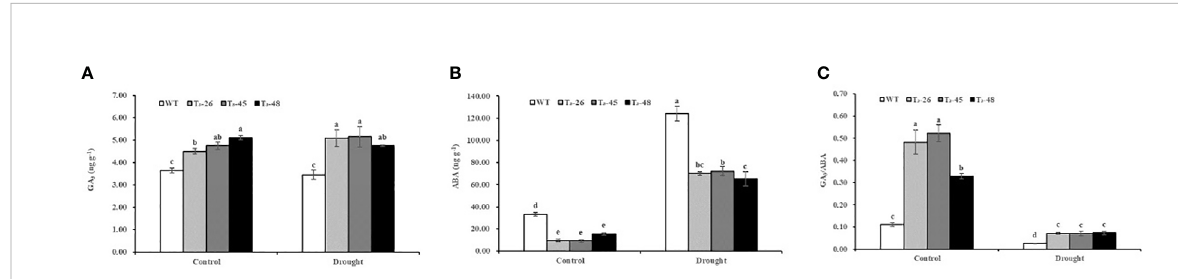
FIGURE 4 NtCPS2 functions in endogenous hormone. (A, B) The content of gibberellin and abscisic acid. (C) Gibberellin to abscisic acid ratio. Error bars represent means ± SD. Statistical analysis was performed using the ANOVA test (p< 0.05) and signi fi cant differences are indicated by different